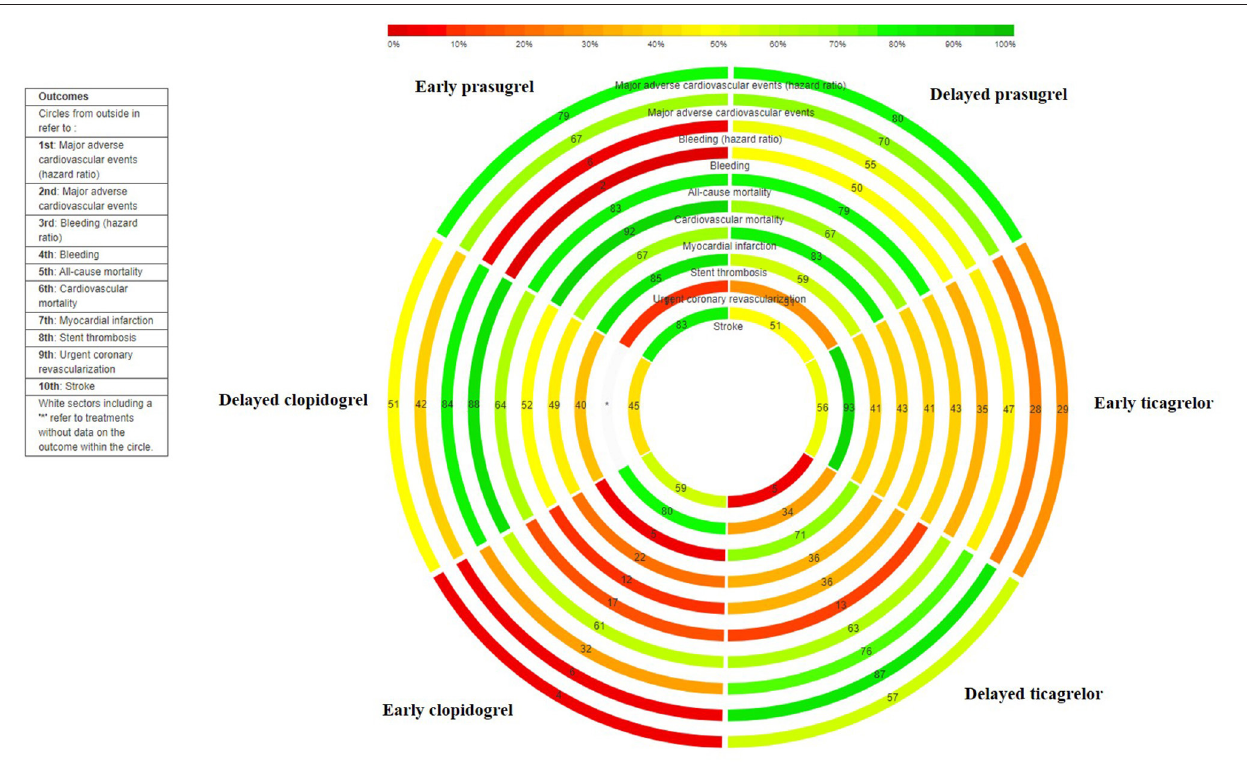
Frontiers in Cardiovascular Medicine |